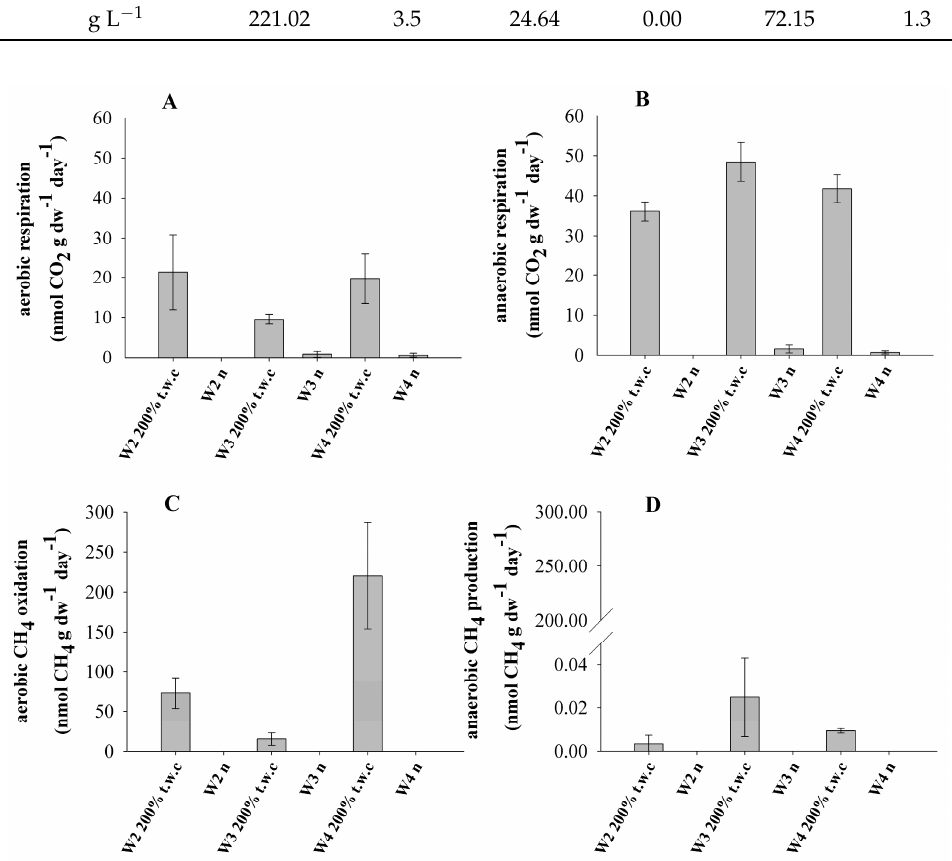
Figure 2. Microbial activity (( A )—aerobic respiration; ( B )—anaerobic respiration; ( C )—aerobic CH 4 oxidation; ( D )—anaerobic CH 4 production) in marine sediments under different moisture (natural—n and saturated—200% t.w.c.) and aeration conditions at 20 ◦ C (error bars represent standard deviation, n = 3).